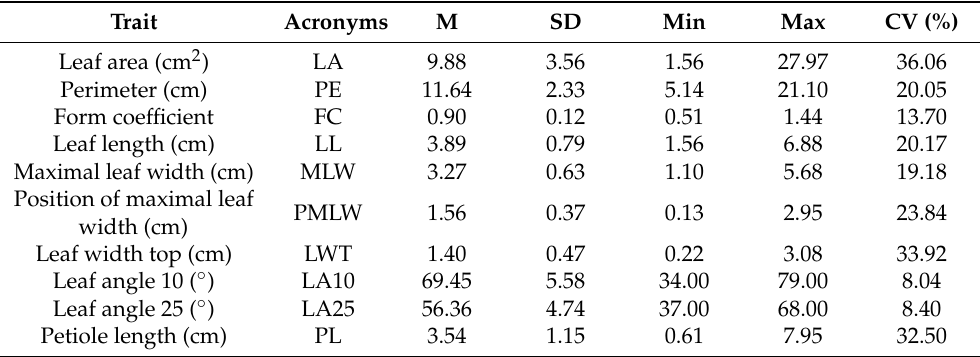
Table 1. Descriptive statistics for analyzed traits of Pyrus pyraster leaves from 19 studied popula- tions. M—arithmetic mean; SD—standard deviation; Min—minimal value; Max—maximal value; CV—coefficient of variation